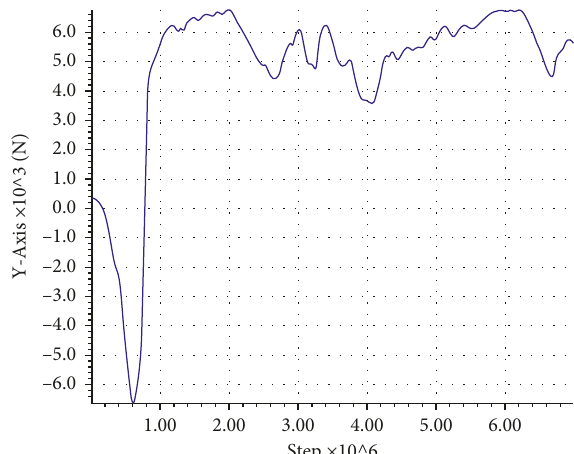
Figure 14: Axial force diagram of the anchor pile No.1 with a rock- socketed depth of 5 cm.